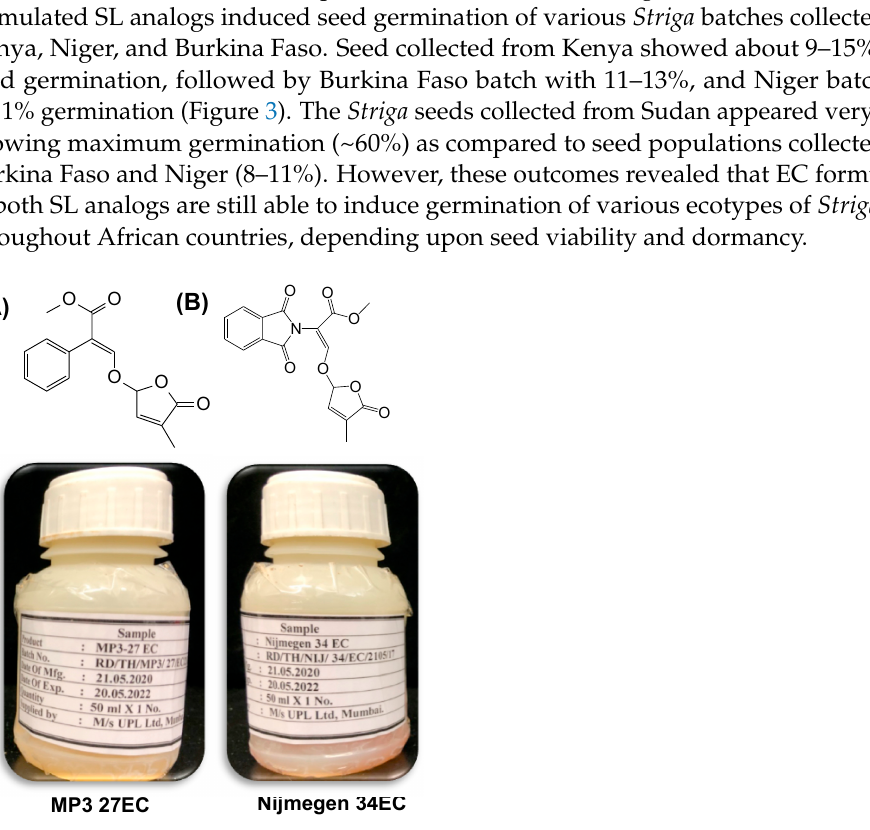
Figure 2. Comparison of EC formulated SL analogs MP3 27EC and Nijmegen 34EC with AG formu- lated SL analogs for Striga seed germination. ( A ) The scheme of the experiment conducted for Striga seed germination bioassays. ( B ) Effect of various concentrations of both formulations (AG and EC)